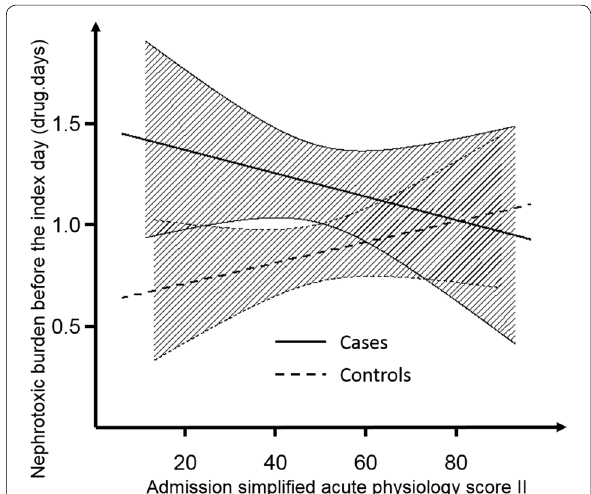
Fig. 4 Nephrotoxic burden according to severity of disease. Whereas an increase in nephrotoxic burden before the index day (see text for definition) was observed among control patients not developing or worsening acute kidney injury in the intensive‑care unit (control patients) within increasing severity, a decrease was observed for cases of acute kidney injury occurrence or